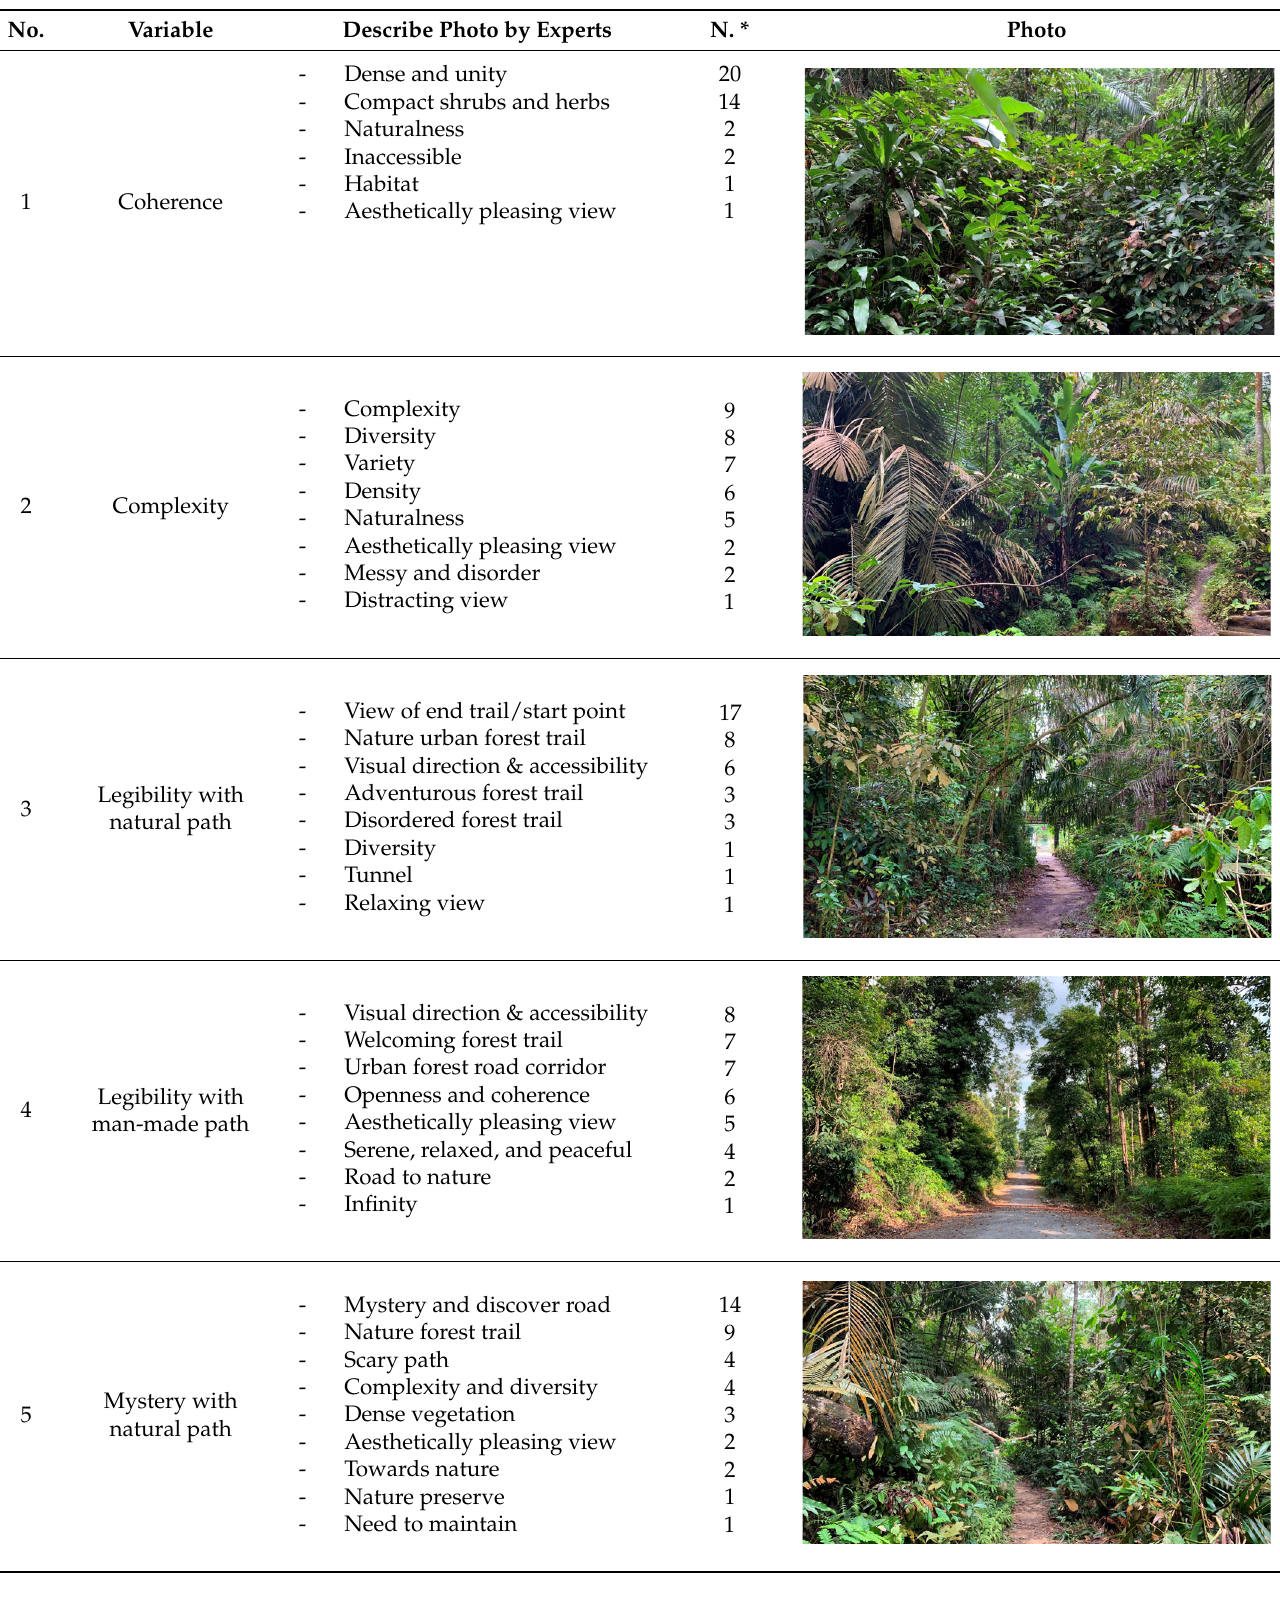
Table 7. Expert descriptions of the photos for validation of the data classifications.